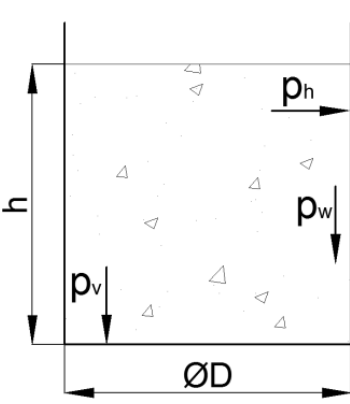
Figure 1: Pressures of the internal storage